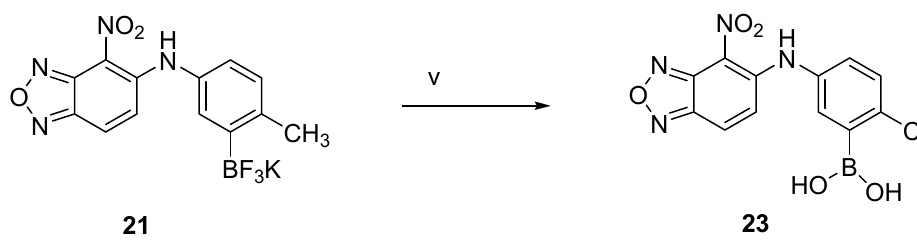
Scheme 2. Synthesis of boronic acid derivative ( 23 ). Reagents and conditions: (v) SiO 2 , EtOAc, H 2 O 1–2 h, room temperature (25 °C) 64%.